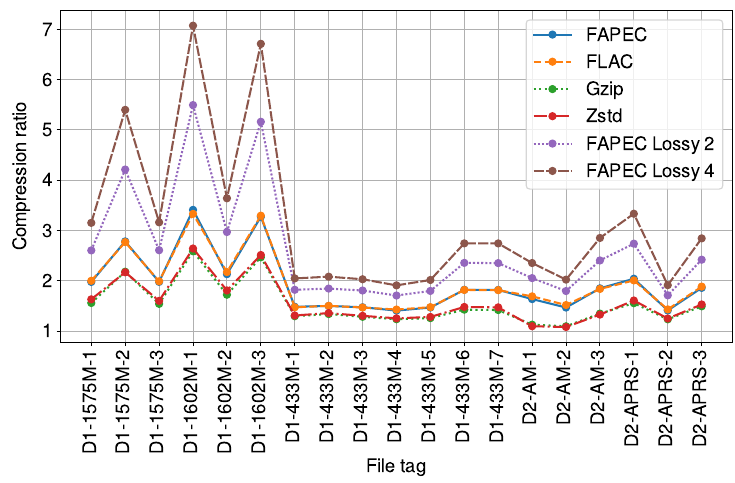
Figure 1. Lossless and near-lossless (levels 2 and 4) compression ratios of the RF signals.